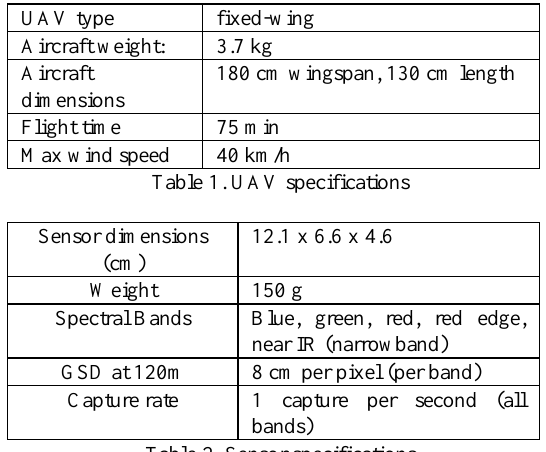
Table 2. Sensor specifications